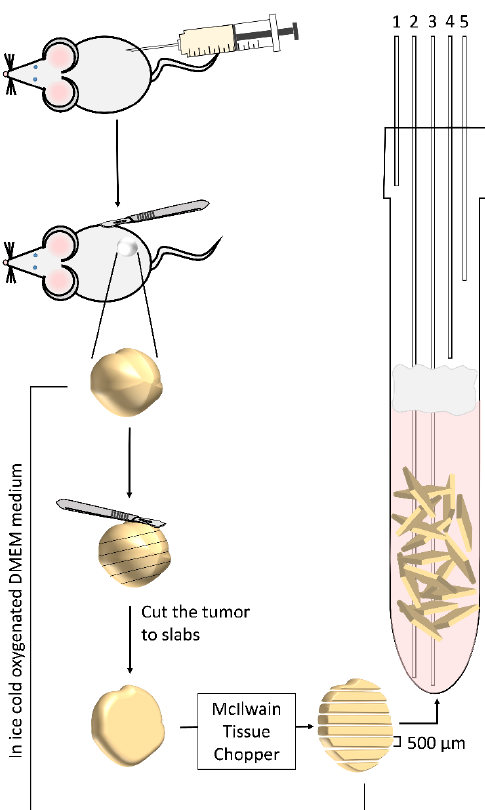
Figure 1. Obtaining xenograft tumors in mice, production of precision cut tumor slices, and maintenance of the slices’ viability in an NMR tube. MCF7 human breast cancer cells ((1 – 4) × 10 6 ) were injected subcutaneously to an immune deficient female mouse. When the tumor reached the size of 1 cm 3 , the tumor was resected (under anesthesia) and placed in ice-cold medium. To cope with the rigidity of the tumor, in order to produce precision-cut tissue slices, the tumor was first cut into ca. 1 – 2 mm slabs, and then each slab was sliced to 500 µm slices and placed in a 10 mm NMR tube with perfusion of DMEM medium at 37 °C at a rate of 4 ml/min. The lines going in and out of the NMR tube are marked as follows: 1. Humidified 95%/5% O 2 /CO 2 atmosphere; 2. NMR compatible temperature probe; 3. Medium inflow line; 4. Medium out-flow line; 5. Backup outflow line. A filter made of cotton balls (colored gray in the figure) was placed a few cm above the slices to prevent suction of the occasional floating slice into the out-flow lines. The slices were kept at the bottom of the tube at the region visible to the NMR probe due to gravity and possible inter slice adhesion and the gentle perfusion generally did not displace